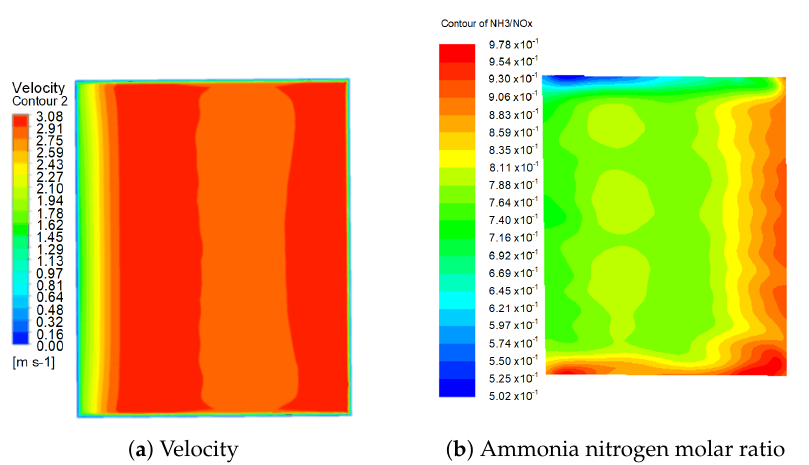
Figure 5. Flow and concentration characteristics of original design. ( a ): Velocity distribution diagram of section in front of the catalyst layer. ( b ): Distribution diagram of ammonia–nitrogen molar ratio of section in front of the catalyst